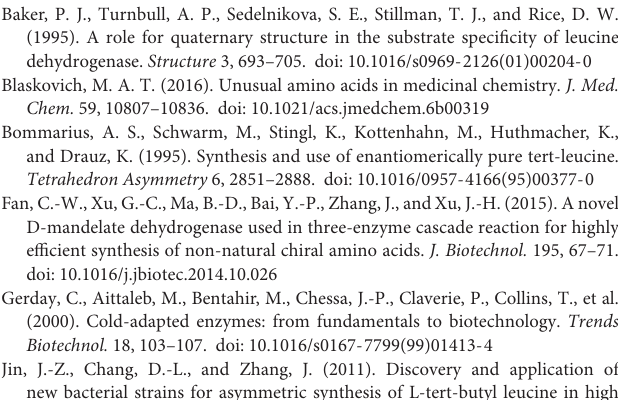
Supplementary Figure 1 | The PCR and double digestion detection of recombinant E. coli BL21(DE3)/pACYCDuet-1- Cb FDH. Supplementary Figure 2 | The PCR and double digestion detection of recombinant E. coli BL21(DE3)/pACYCDuet-1- Cb FDH- Pf LeuDH. Supplementary Figure 3 | The HPLC analysis of reaction mixture at Thermo Hypersil C18 column. Supplementary Figure 4 | The HPLC analysis of L -tert-leucine at Thermo Hypersil C18 column. Supplementary Figure 5 | The HPLC analysis of D -tert-leucine at Thermo Hypersil C18 column. Supplementary Figure 6 | The UPLC-MS analysis of TMP. Supplementary Figure 7 | The UPLC-MS analysis of L